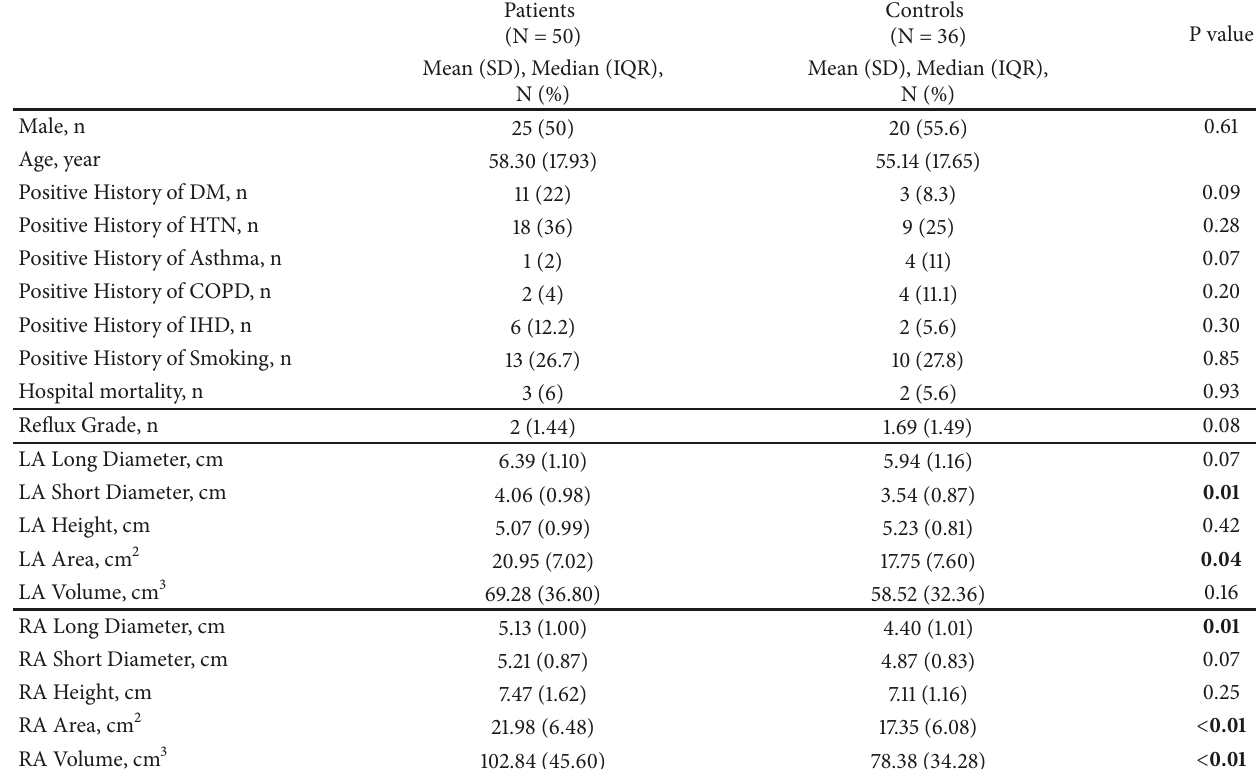
Table 1: Basic demographic and clinical information in case and control groups.